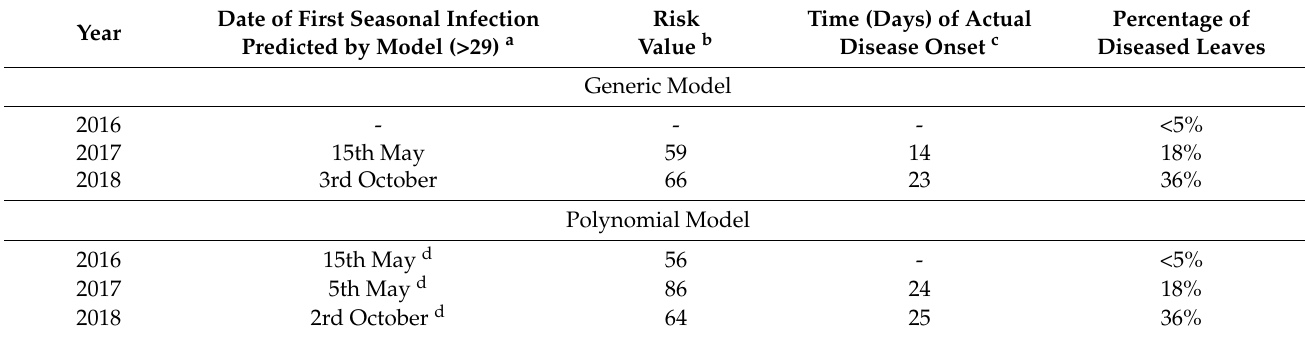
Figure 3. Average temperature, rainfall, and leaf wetness for the period May to December in 2016, 2017 and 2018. In 2016, the polynomial model predicted risk >29 on the 15th, 20th and 31st of May, 23th September, 10th and 15 October, 8th November and 1st December (Table 1). In contrast, no prediction of risk >29 was given from the generic model in the period April–December 2016. Very low incidence symptoms (percentage of diseased leaves < 5%) of the disease were observed in the unsprayed control trees at the same period. The mean temperature was 18.6 ◦ C in May, which increased to 24.8 ◦ C, 26.6 ◦ C and 26.2 ◦ C in June, July and August, and decreased to 22.7 ◦ C, 17.8 ◦ C, 13.8 ◦ C in September, October and November respectively. The above temperatures were not a limiting factor for infections of the olive trees by the fungus V. oleaginea . In contrast, the total degree of hourly leaf wetness was very low in the period of May to December and not favorable for the development of the disease. Table 1. Dates of the first seasonal infection of Venturia oleaginea predicted by the Generic and Polynomial models in 2016, 2017 and 2018; corresponding values of the risk index calculated by the model; times of actual disease onset; and percentage of diseased